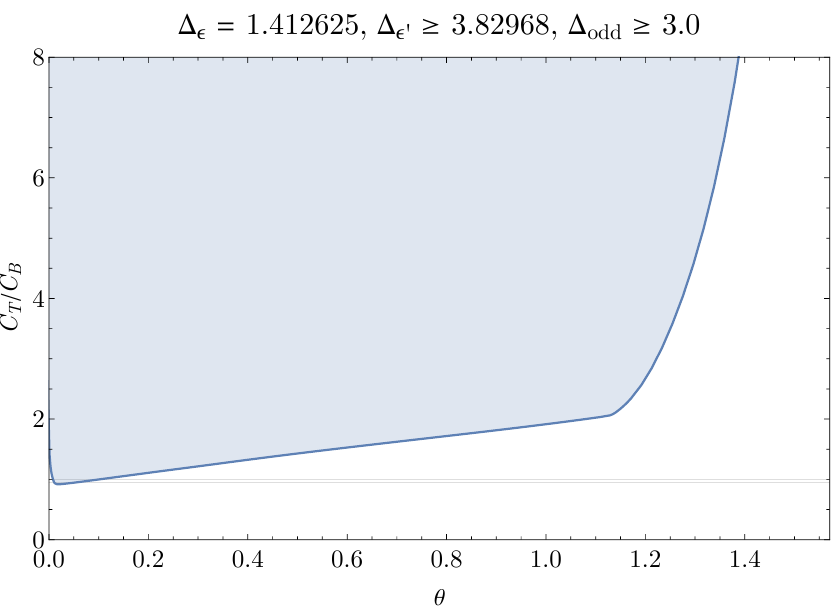
Figure 15 . Lower bound on C T as a function of (cid:18) assuming known low-lying gaps in the parity-even scalar spectrum in the 3d Ising CFT, combined with the assumption that the leading parity-odd scalar is irrelevant.